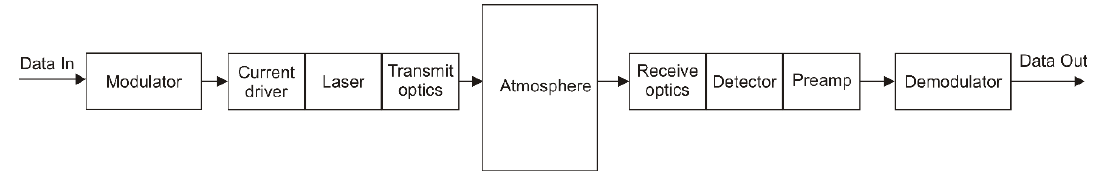
Figure 1. Block scheme of FSO operation.